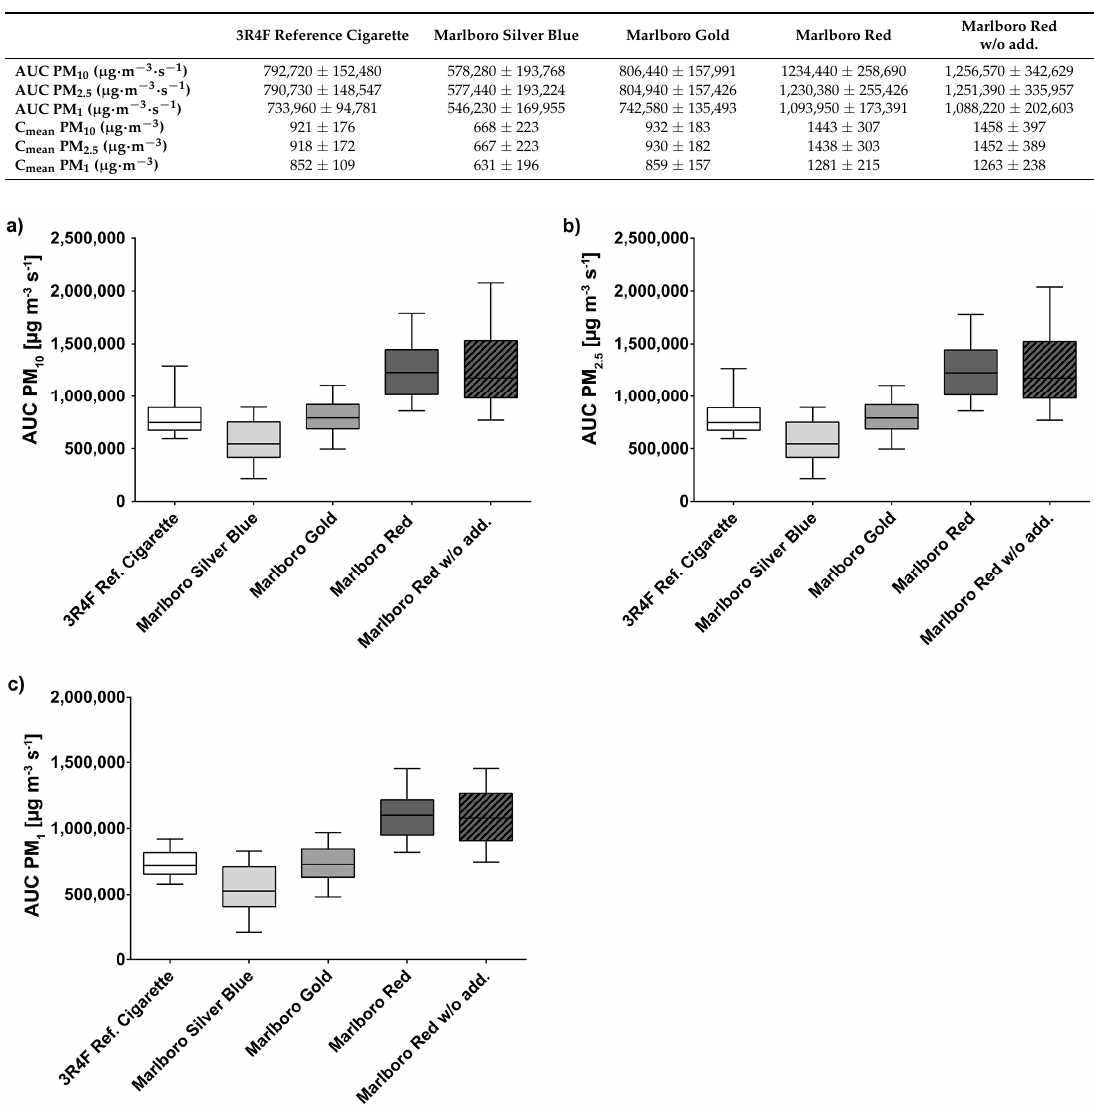
Marlboro Red w/o add.